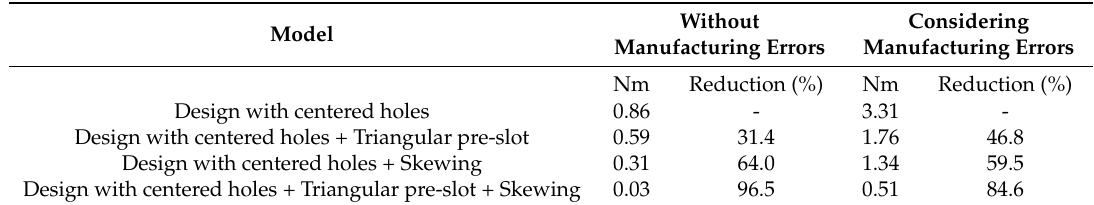
Table 4. Comparison of the maximum cogging torque values of PMSG with centered holes and the different models considering